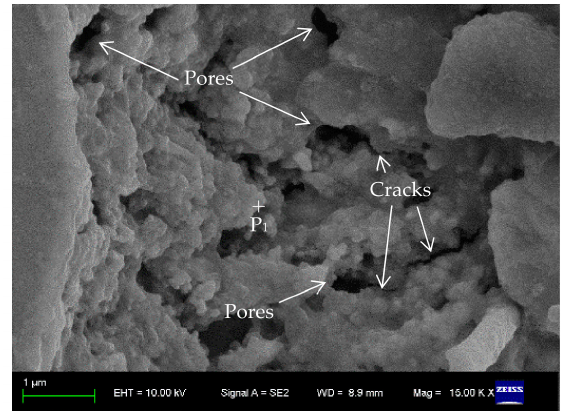
Figure 5. Microstructure of sealing layer under scanning electron microscope (SEM) ( P = 80 W, v = 2 mm /